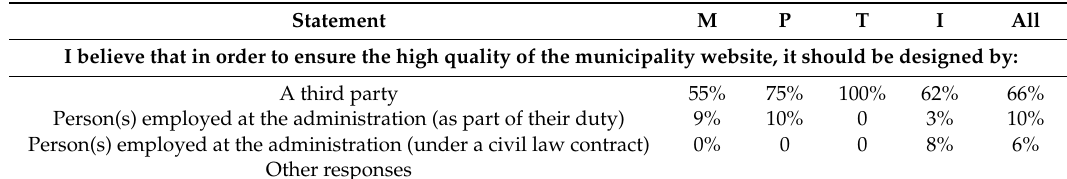
Table 8. Survey results: ‘Website quality assurance’ ( n =